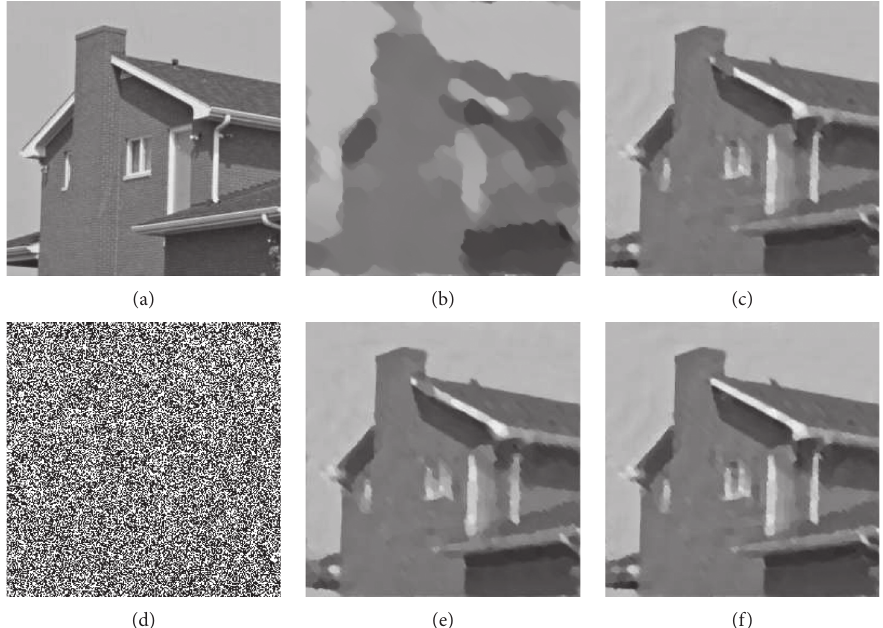
Figure 6: The recovery results (House 256) by Motion blur with 90% SP noise. (a) Original. (b) TVL1, PSNR � 18.7106. (c) TVSCAD, PSNR � 25.0094. (d) Motion blur (lev � 0.9). (e) TVLog, PSNR � 24.2055. (f) LogTVSCAD, PSNR � 25.8013.